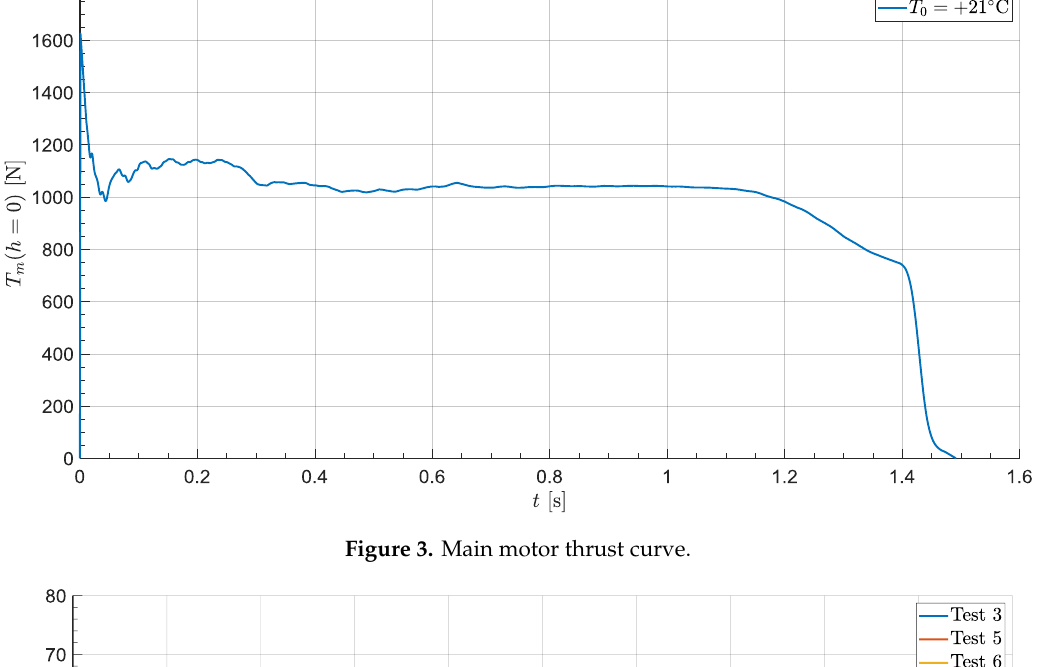
Figure 3. Main motor thrust curve.